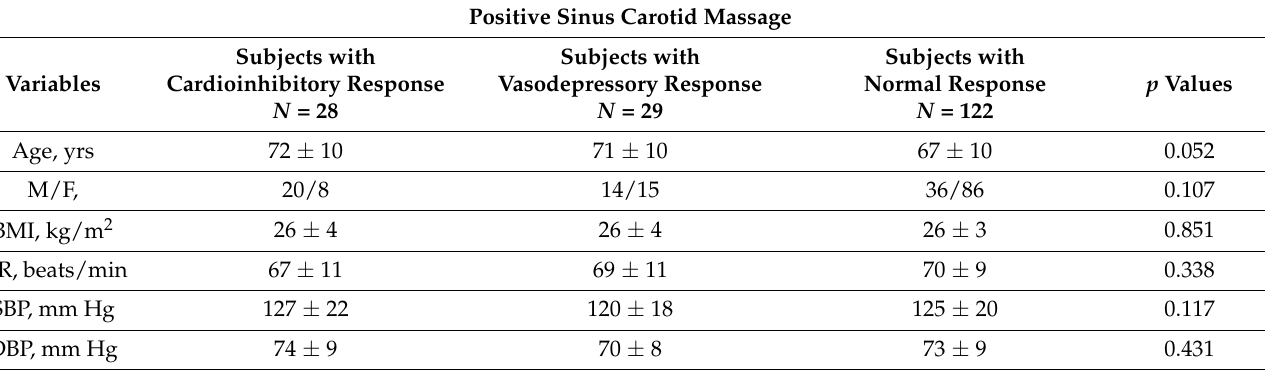
Table 1. General characteristics of the three study